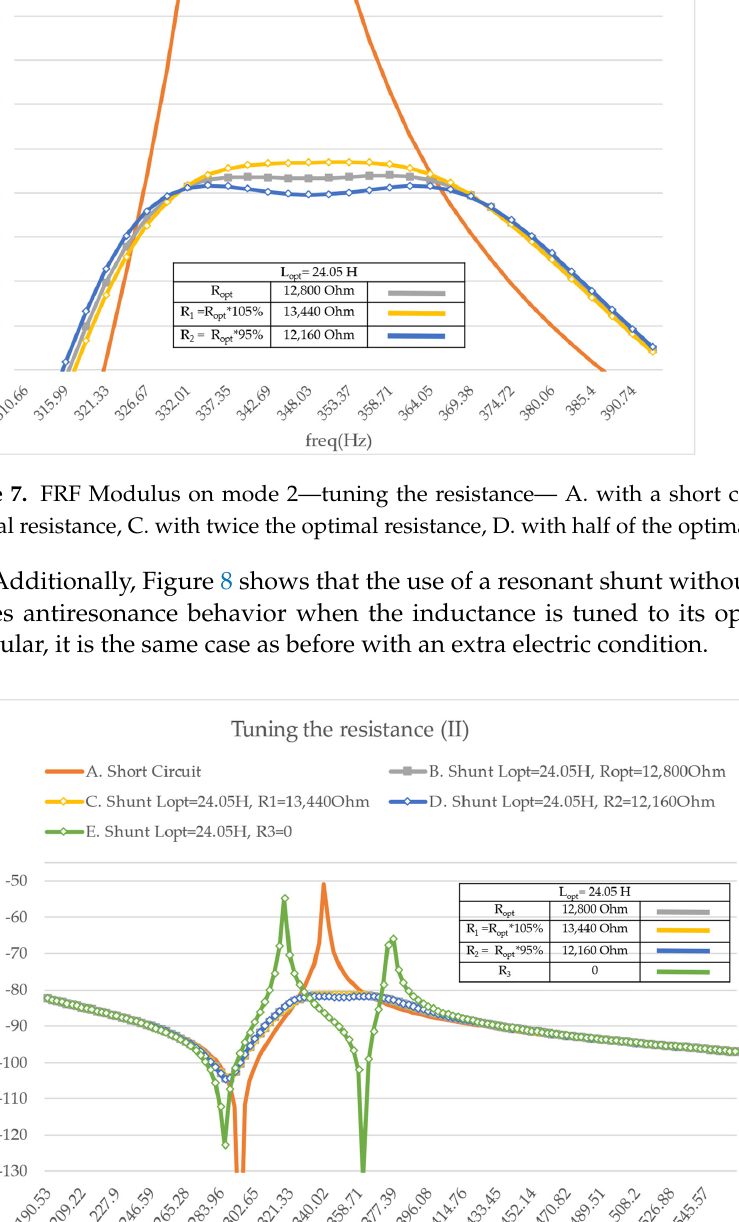
Figure 9. FRF Modulus on mode 2 — tuning the inductance — A. with a short circuit, B. with the op- timal resistance and inductance, C. with 105% of the optimal inductance, D. with 95% of the optimal inductance, E. with the optimal resistance and no inductance.